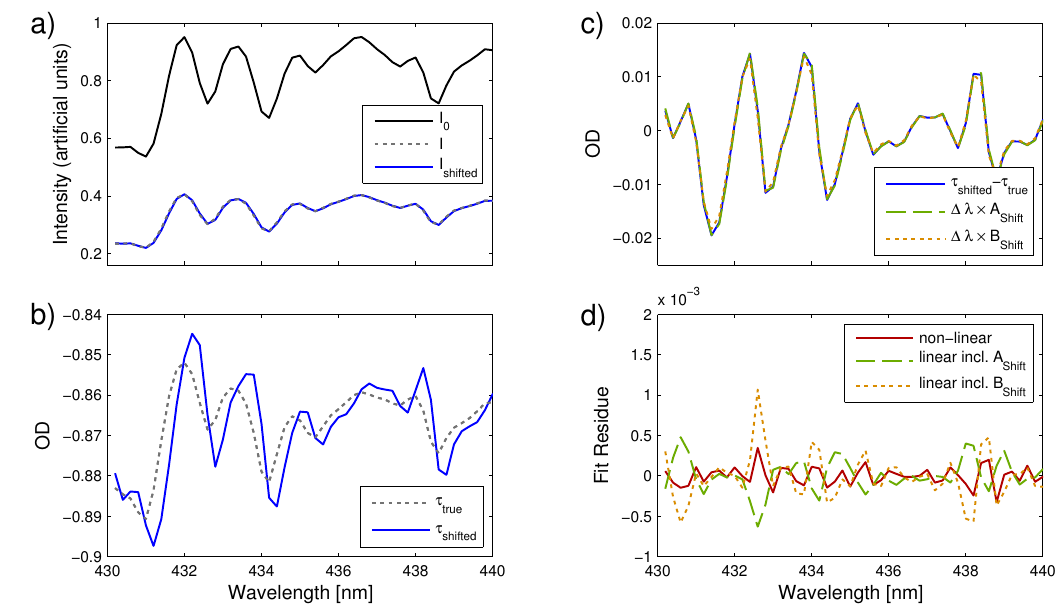
Fig. 3. Illustration of the linear and non-linear DOAS fits for a simple synthetic spectrum I including the Ring effect and NO 2 absorption. (a) Intensities I 0 , I and I shifted by 0.02nm. (b) OD (ln I ) for the original and shifted Intensities. (c) Difference of the OD from shifted I 0 and original Intensities (blue), and the “shift-spectrum” as defined in Eqs. (4) and (16), scaled by the applied shift of 0.02nm (green/orange). (d) Fit residues for the non-linear fit (red) and the linear fit with shift and stretch pseudo-absorbers included (green/orange).